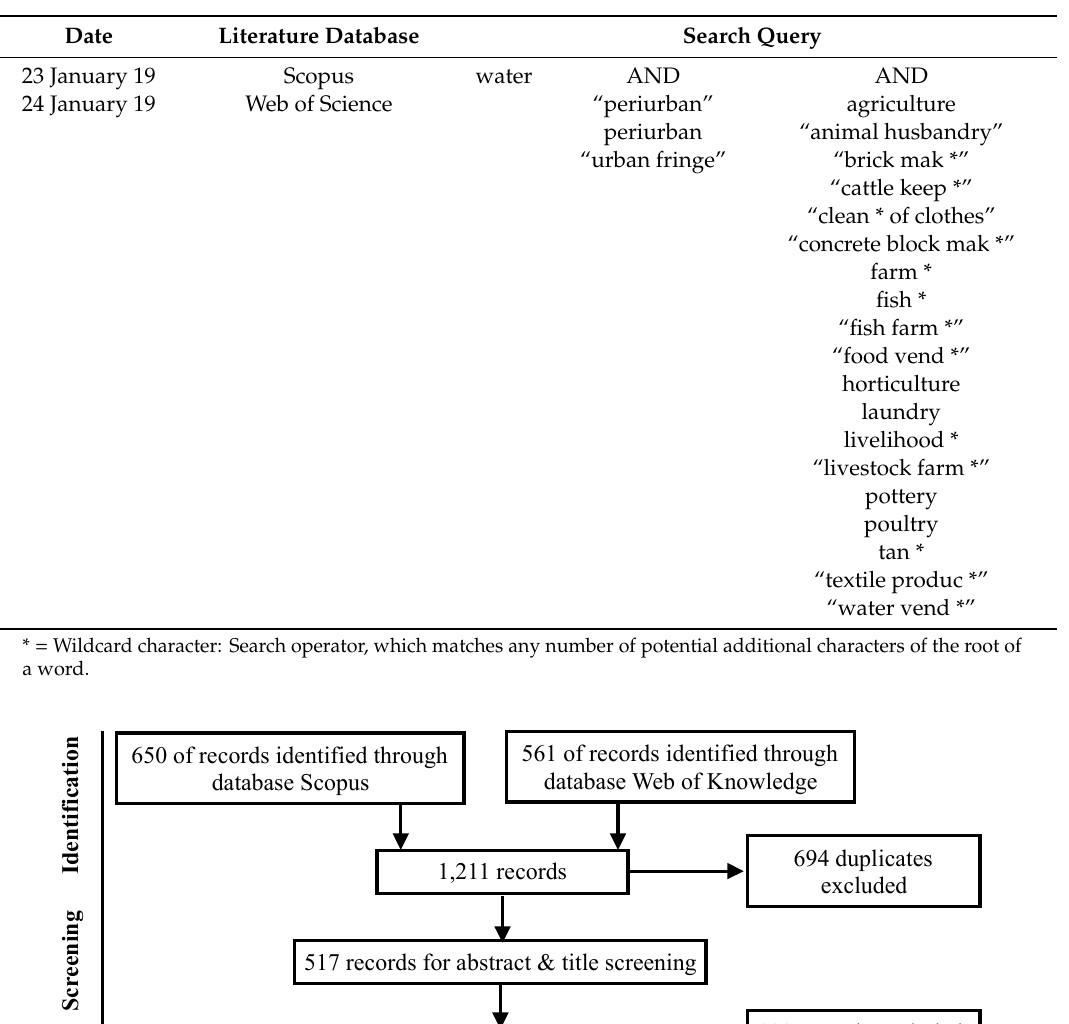
Table 1. Keywords used for identifying relevant literature.